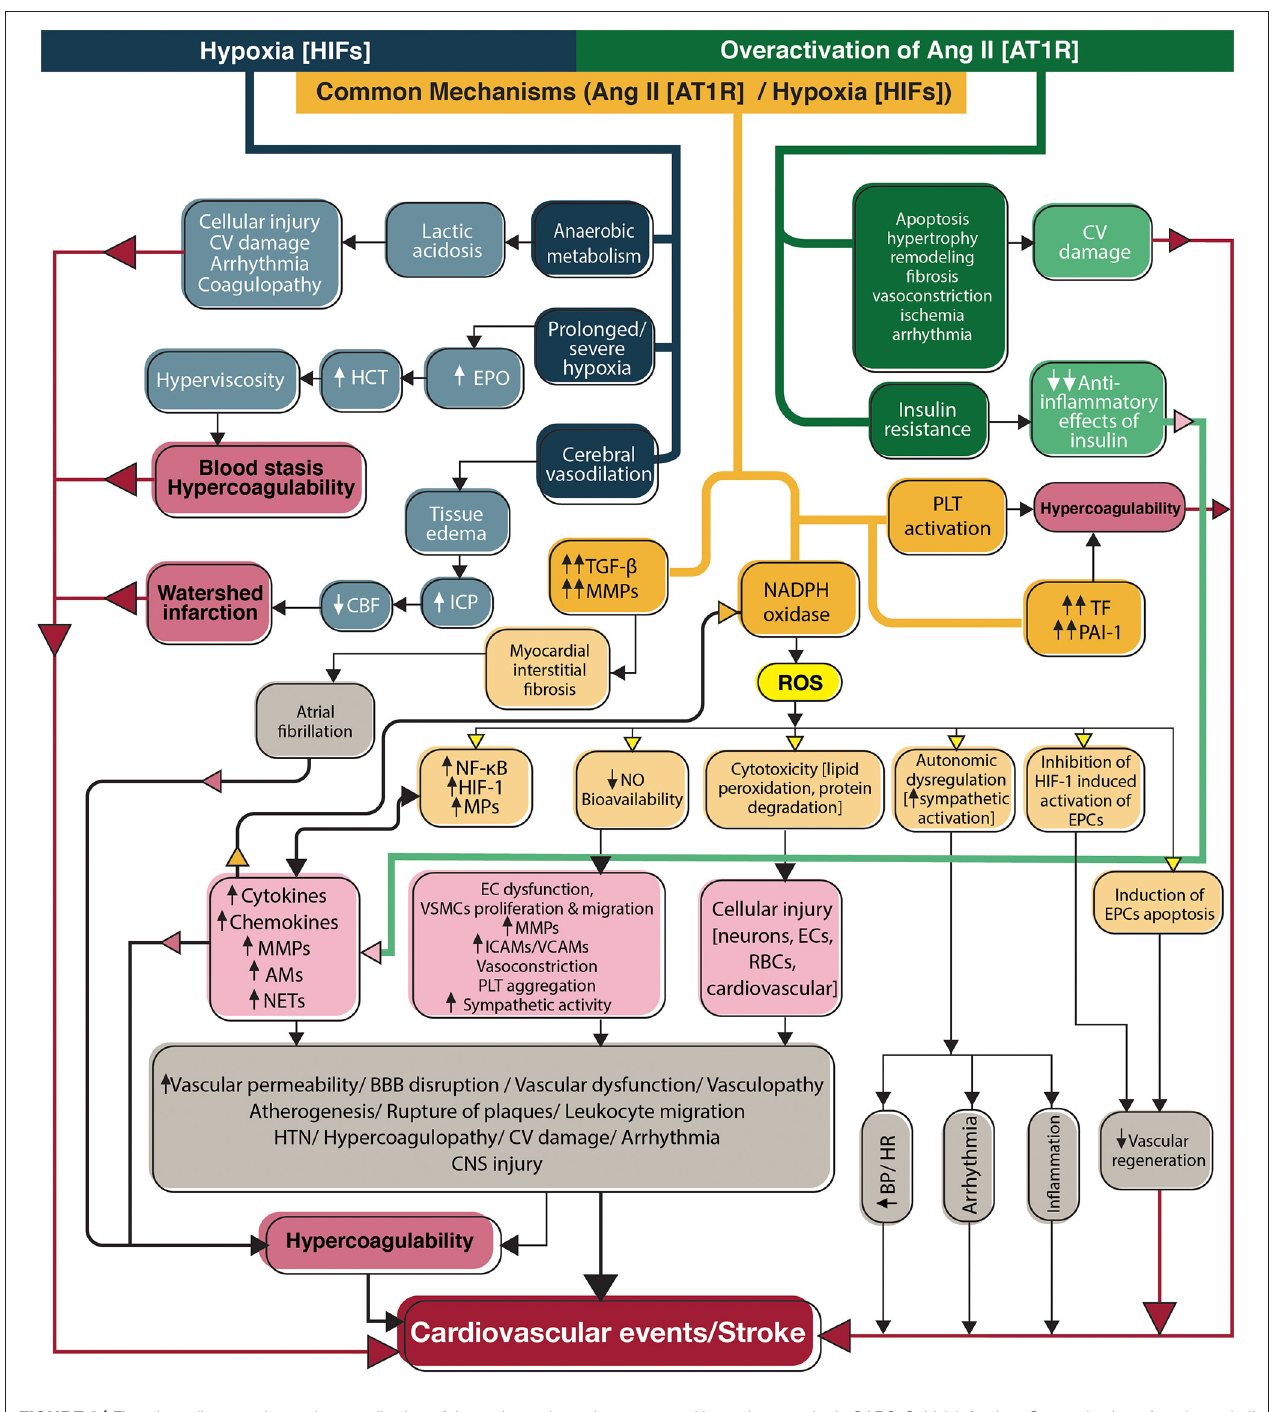
FIGURE 3 | Flowchart diagram shows the contribution of the renin-angiotensin system and hypoxia to stroke in SARS-CoV-2 infection. Overactivation of angiotensin II signaling pathways and hypoxia directly activate inflammation and coagulation systems, in addition to indirect activation through induction of NADPH, to produce reactive oxygen species (yellow box). Ang II acts through its main receptor, angiotensin type 1 receptor, and hypoxia mediates its effects through transcription factors, hypoxia-inducible factors. CV, Cardiovascular; EPO, Erythropoietin; HCT, Hematocrit; ICP, Intracranial pressure; CBF, Cerebral blood flow; TGF- β , Transforming growth factor-beta; MMPs, Matrix metallopeptidases; NADPH, Nicotinamide adenine dinucleotide phosphate; ROS, Reactive oxygen species; PLT, Platelet; TF, Tissue factor; PAI-1, Plasminogen activator inhibitor-1; HIFs, Hypoxia-inducible factors; NF- κ B, Nuclear factor-kappa B; HIF-1, Hypoxia-inducible factor-1; MPs, Microparticles; AMs, Adhesion molecules; NETs, neutrophil extracellular traps; NO, Nitric oxide; EC, Endothelial cell; VSCM, Vascular smooth muscle cell; ICAMs, Intercellular adhesion molecules; VCAMs, Vascular cell adhesion molecules; BBB, Blood-brain barrier; HTN, Hypertension; CNS, Central nervous system; RBCs, Red blood cells; BP, Blood pressure; HR, Heart rate; EPCs, Endothelial progenitor cells; Ang II, Angiotensin II; AT1R, Angiotensin type 1 receptor; HIFs, Hypoxia-inducible factors.